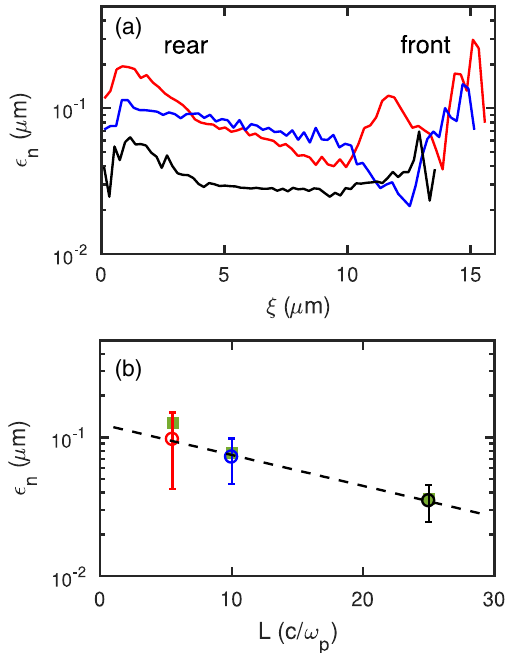
FIG. 4. Emittance of the injected beam for three different ramp lengths. The upper and lower shelf densities are 6 and 2 . 2 × 10 18 cm − 3 , respectively, and the ramp length changes from 5 to 25 c= ω p . The slice emittance of the injected beam is shown in (a) for L ¼ 5 c= ω p (red), L ¼ 10 c= ω p (blue), and L ¼ 25 c= ω p (black). The front of the injected beam is marked in (a). The average and standard deviation of the slice emittance of the injected beam are shown in (b) by circles and error bars, respectively. The green squares show the projected emittance of the injected beam. The dashed line is the best linear fit to the slice emittance data. The emittance is evaluated after the beam being accelerated for ∼ 100 c= ω p so that the beam has gained a moderate energy ( ¯ γ ≈ 74